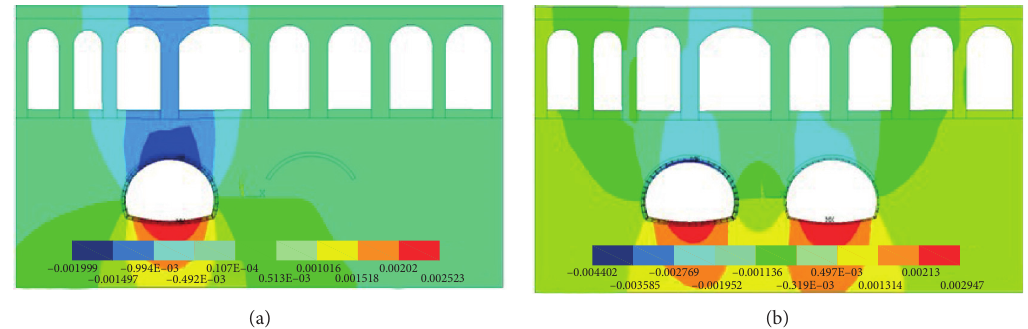
Figure 7: Overall vertical deformation of the model. (a) After the excavation of the left tunnel. (b) After the excavation of the right tunnel.